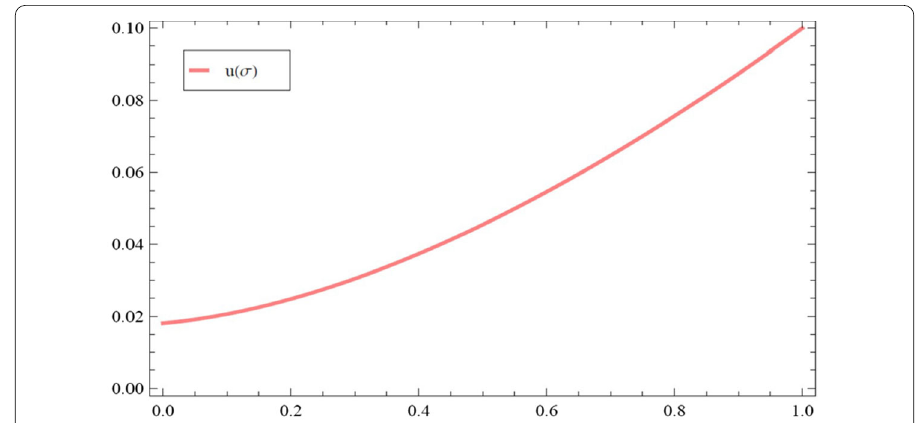
Figure 1 The solution u ( σ ) of (22) with the given boundary conditions